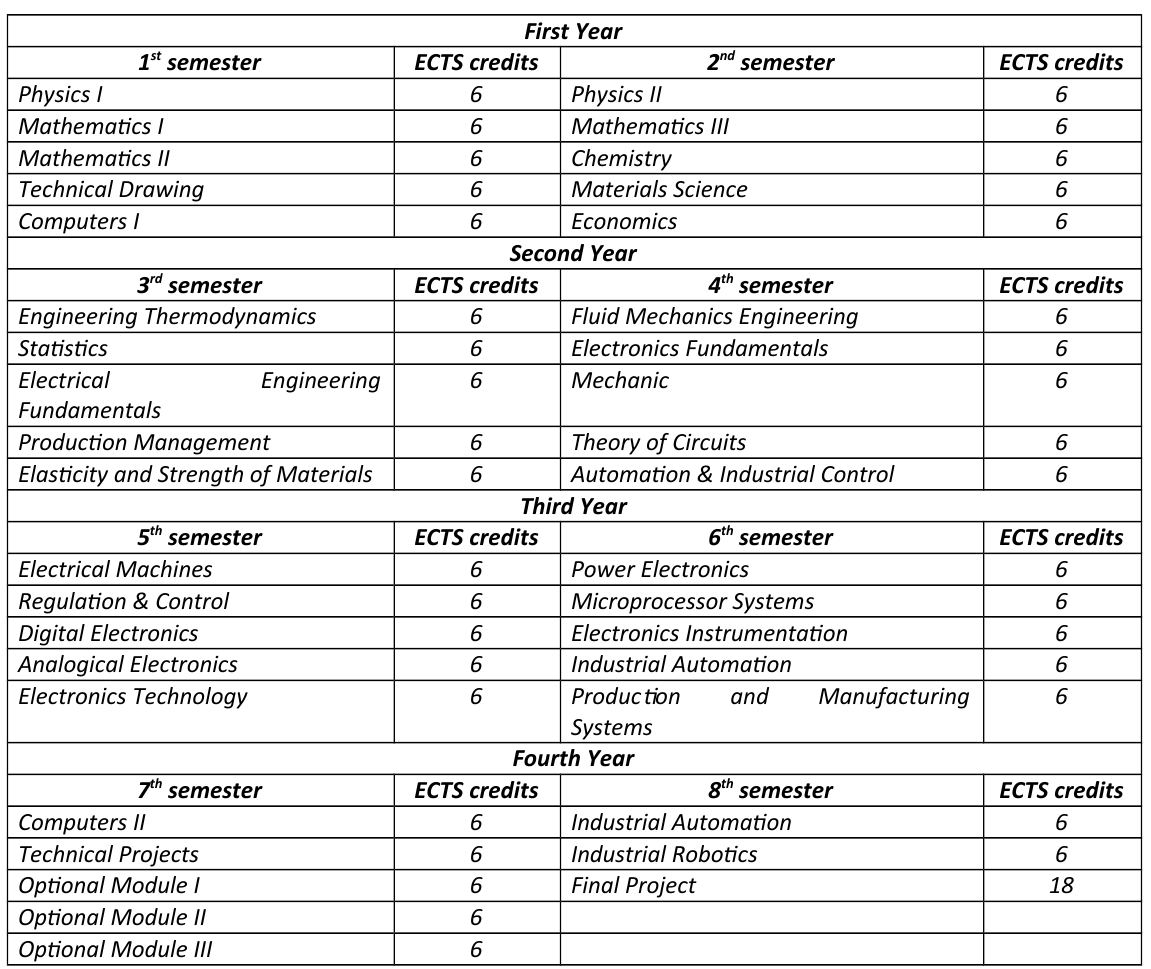
Table 1. Electronics and Control Engineering Degree at the University of